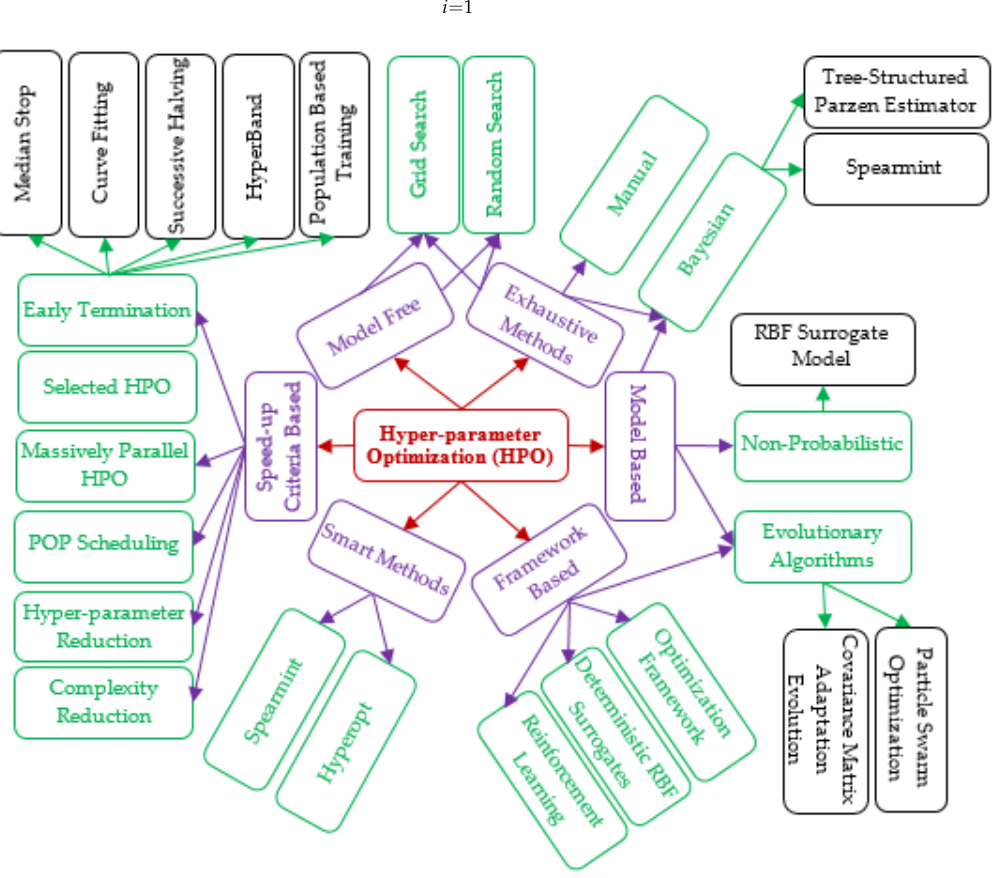
Figure 1. Different hyper-parameter optimization techniques.